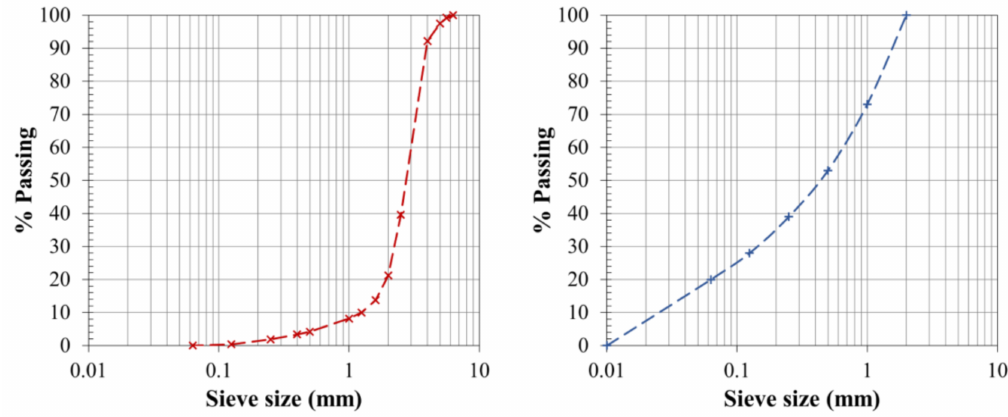
Figure 1. ( a ) Coarse aggregate gradation in PC specimens; ( b ) Sediments gradation used for clogging